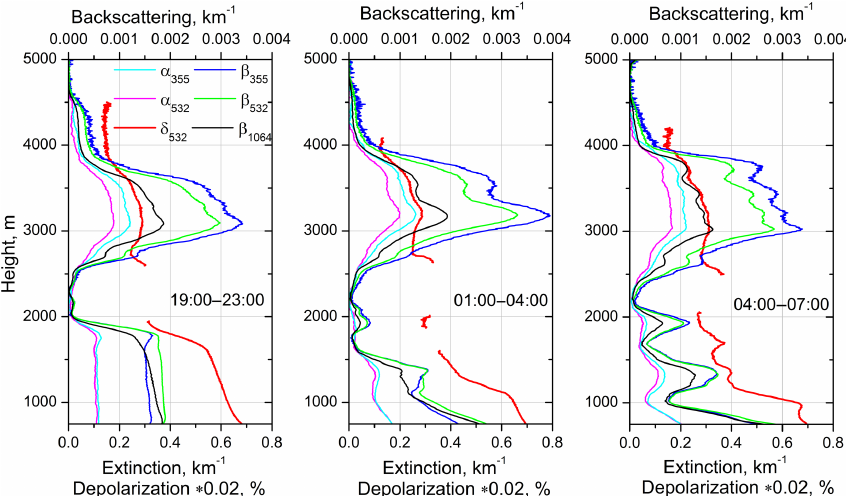
Figure 7. Vertical profiles of the aerosol backscattering ( β 355 , β 532 , β 1064 ) and extinction ( α 355 , α 532 ) coefficients together with the particle depolarization ratio ( δ 532 ) for three temporal intervals: 19:00–23:00, 01:00–04:00, and 04:00–07:00UTC on 24–25 December 2015. The values of δ 532 are multiplied by factor